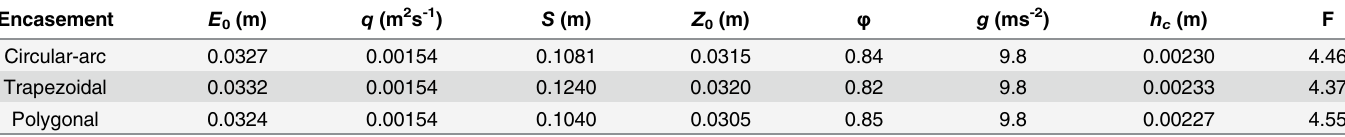
Table 3. Estimated parameters at the vena-contracta for an annual discharge. Encasement Circular-arc